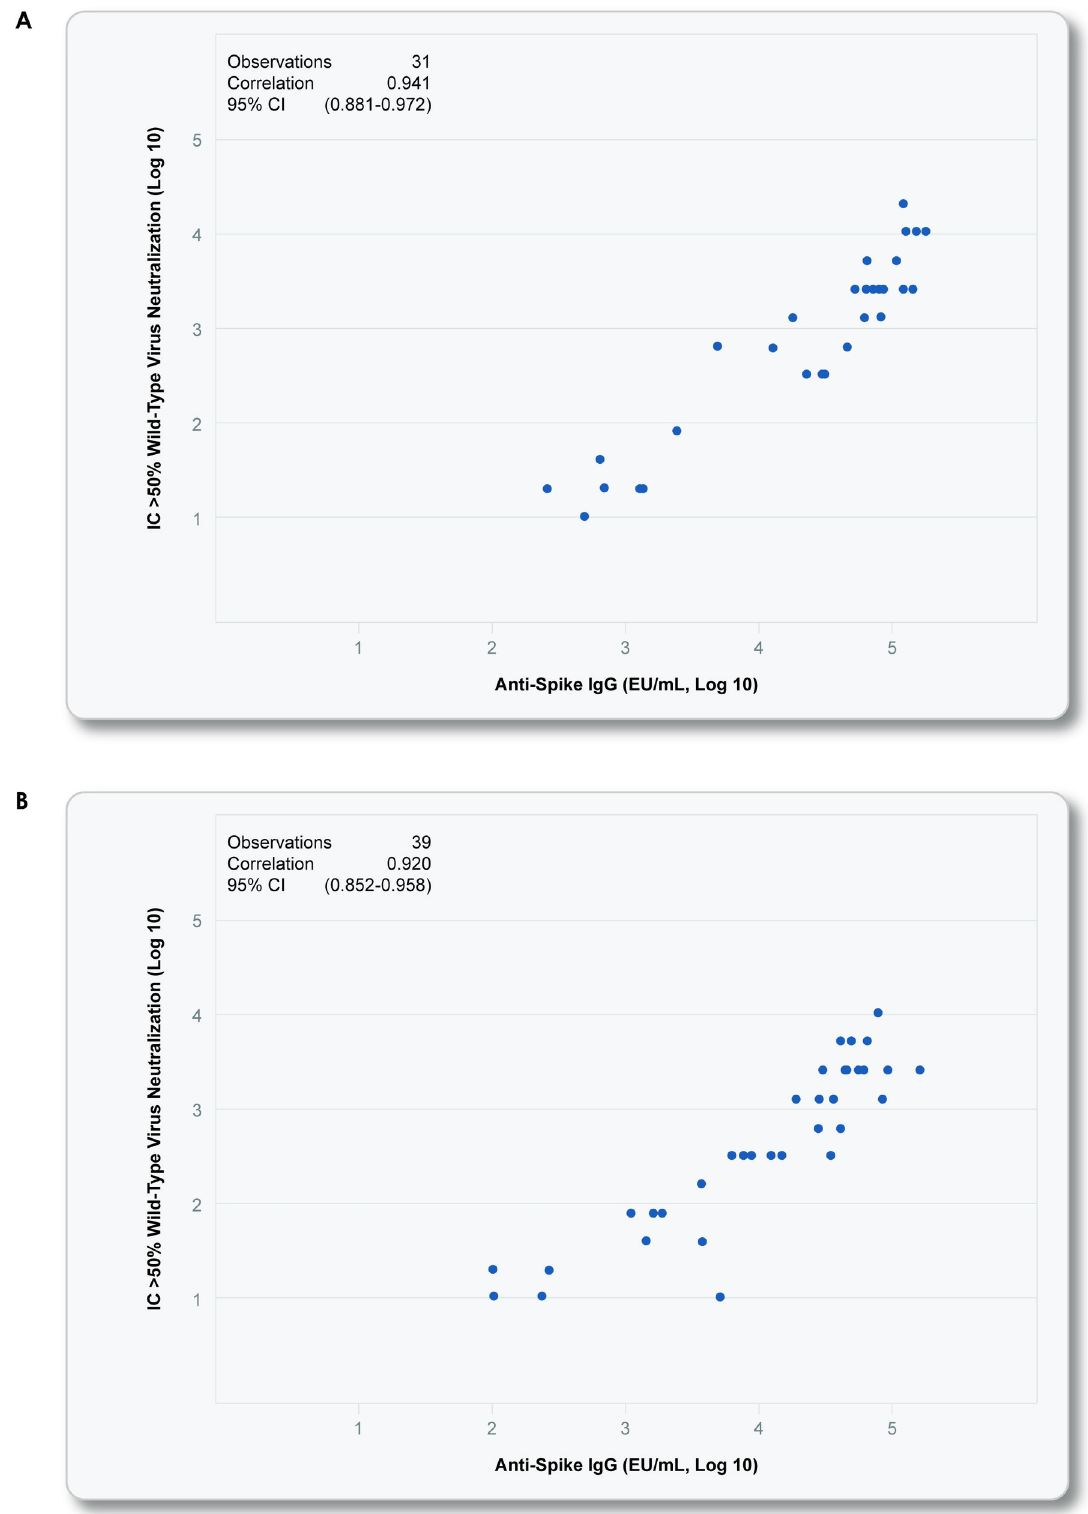
Fig 4. Correlation between SARS-CoV-2 anti-spike IgG and neutralizing antibody responses. Shown is a scattergram and correlation analysis of the neutralizing antibody titers and anti-spike IgG ELISA units for the 5- μ g NVX-CoV2373 2-dose vaccine group (Group